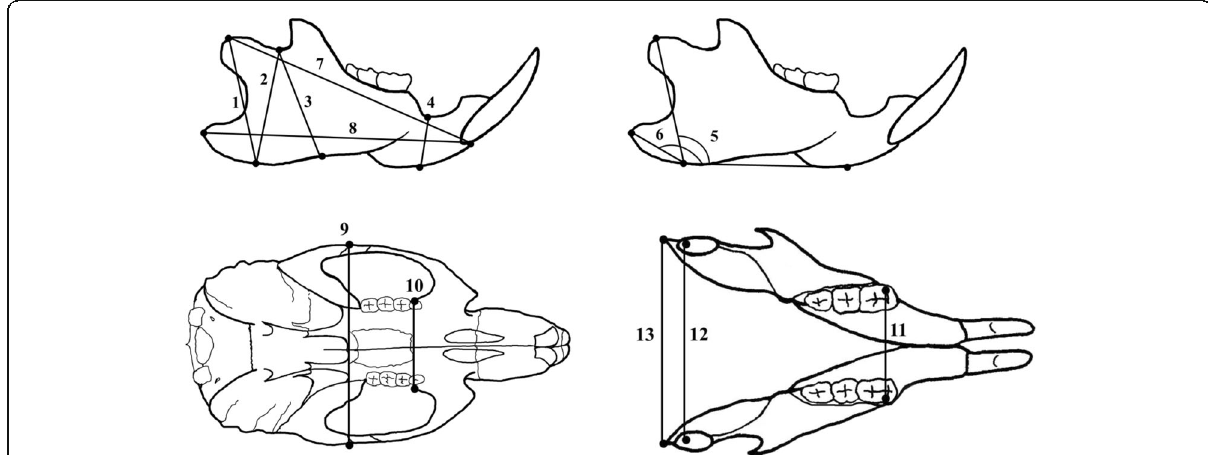
Fig. 2 Anthropometric measurements in the maxillofacial bone of rats. (1) Ramus height I: distance between the Cd and Gn. (2) Ramus height II: distance between the Co and Gn. (3) Ramus height III: distance between the Co and antegonial notch. (4) Corpus height: distance between the mandibular alveolar point and Me. (5) Mandibular plane angle I: angle between the line of Cd-Gn and Gn-Me. (6) Mandibular plane angle II: angle between the line of Go-Gn and Gn-Me. (7) Total mandibular length: distance between the Cd and infradentale. (8) Corpus length: distance between the Go and infradentale. (9) Zygomatic arch width: distance between the bilateral Zy. (10) Maxillary point (key ridge) width: distance between the bilateral key ridge point. (11) Mandibular molar width: distance between the bilateral mesiobuccal cusps of the mandibular first molars. (12) Bicondylar width: distance between the bilateral Cd. (13) Bigonial mandibular width: distance between the bilateral